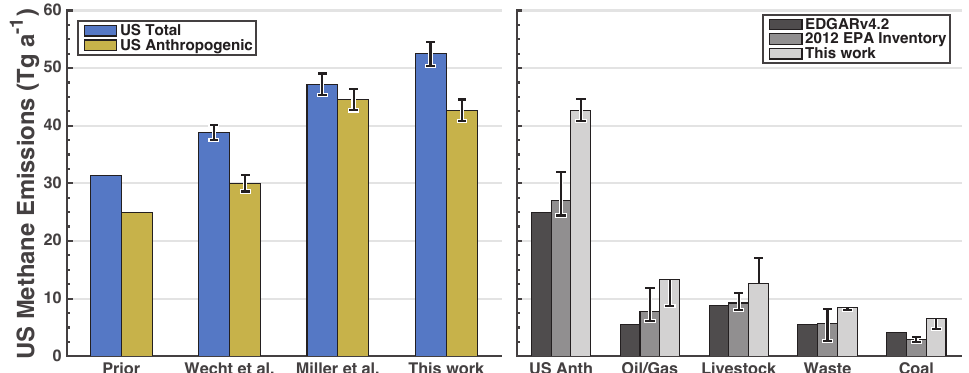
Figure 7. Methane emissions in the contiguous US. The left panel shows our best estimates of total and anthropogenic emissions (this work) compared to the prior (EDGARv4.2 for anthropogenic sources, Pickett-Heaps et al. (2011) for wetlands) and the previous inverse studies of Wecht et al. (2014a) and Miller et al. (2013). The right panel partitions US anthropogenic emissions by source types and compares our results (this work) to EDGARv4.2 and to the 2012 EPA inventory (EPA, 2014). Error bars on sectoral emissions for our results are defined by the sensitivity inversion with 30% prior uncertainty for all state vector